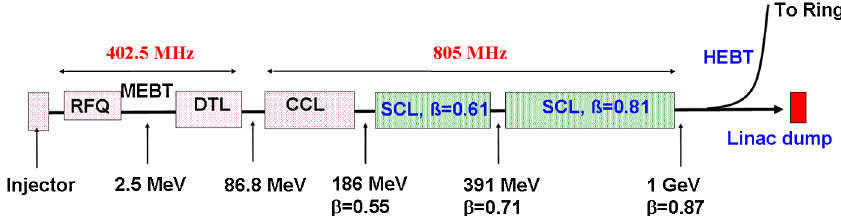
FIG. 1. (Color) SNS linac lattice. Normal conducting section includes injector, RFQ, MEBT, DTL, and CCL; superconducting section includes medium beta (0.61) and high beta